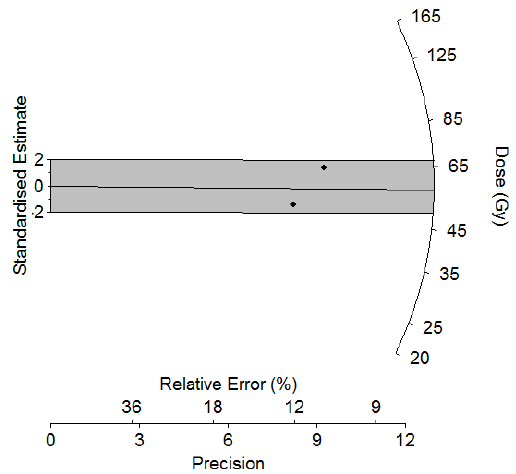
Figure B5. Dose-recovery distribution from two aliquots of sample L15 (A0111). The shaded region corresponds to the standard devia- tion of the measured CAM dose; the line corresponds to the applied radiation